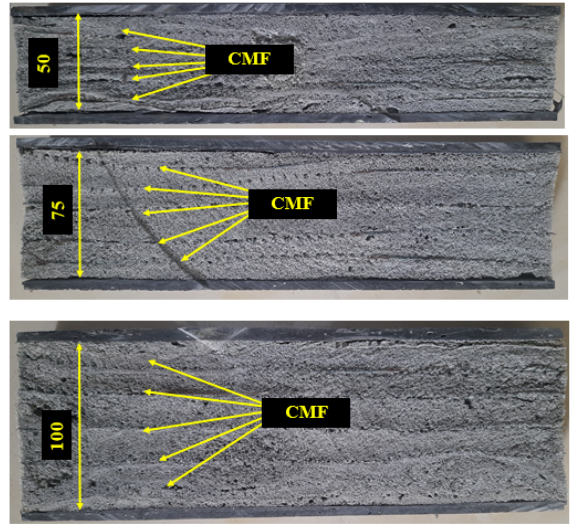
Fig. 2. Sandwich Composite Panel Specimen